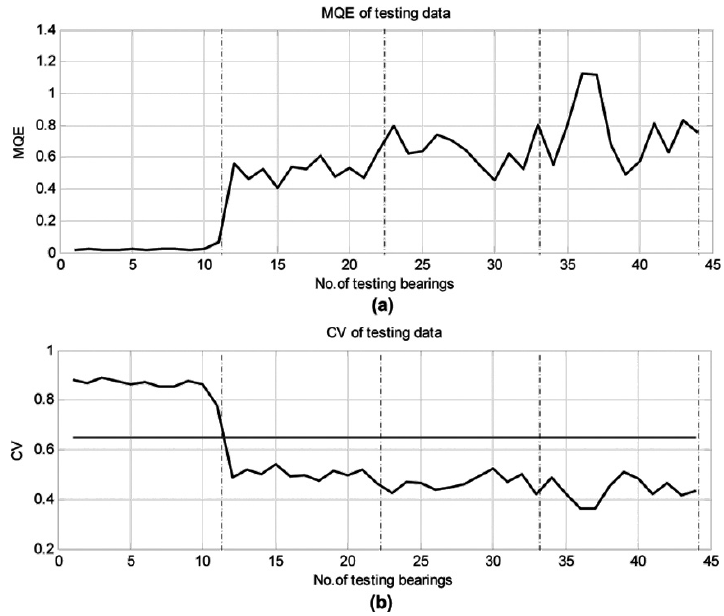
Fig. 9. Bearing health assessment of different fault modes with a defect diameter of 0.014 inches (a) Using MQE (b) Using CV.